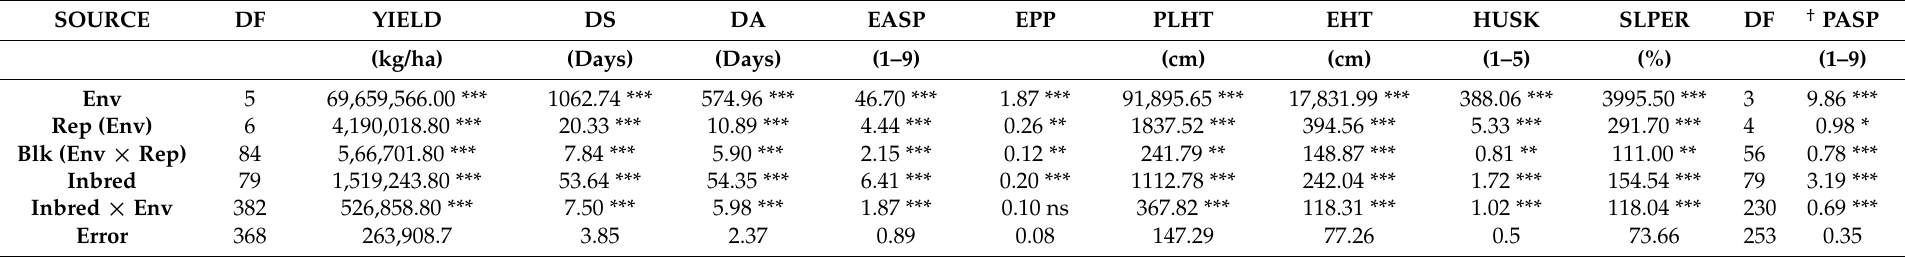
Table 2. Mean squares for grain yield and other agronomic traits of extra-early provitamin A quality protein maize inbreds evaluated across six (low-N, Striga -infested and high-N) environments at Ile-Ife, Mokwa and Abuja in Nigeria in 2016 and